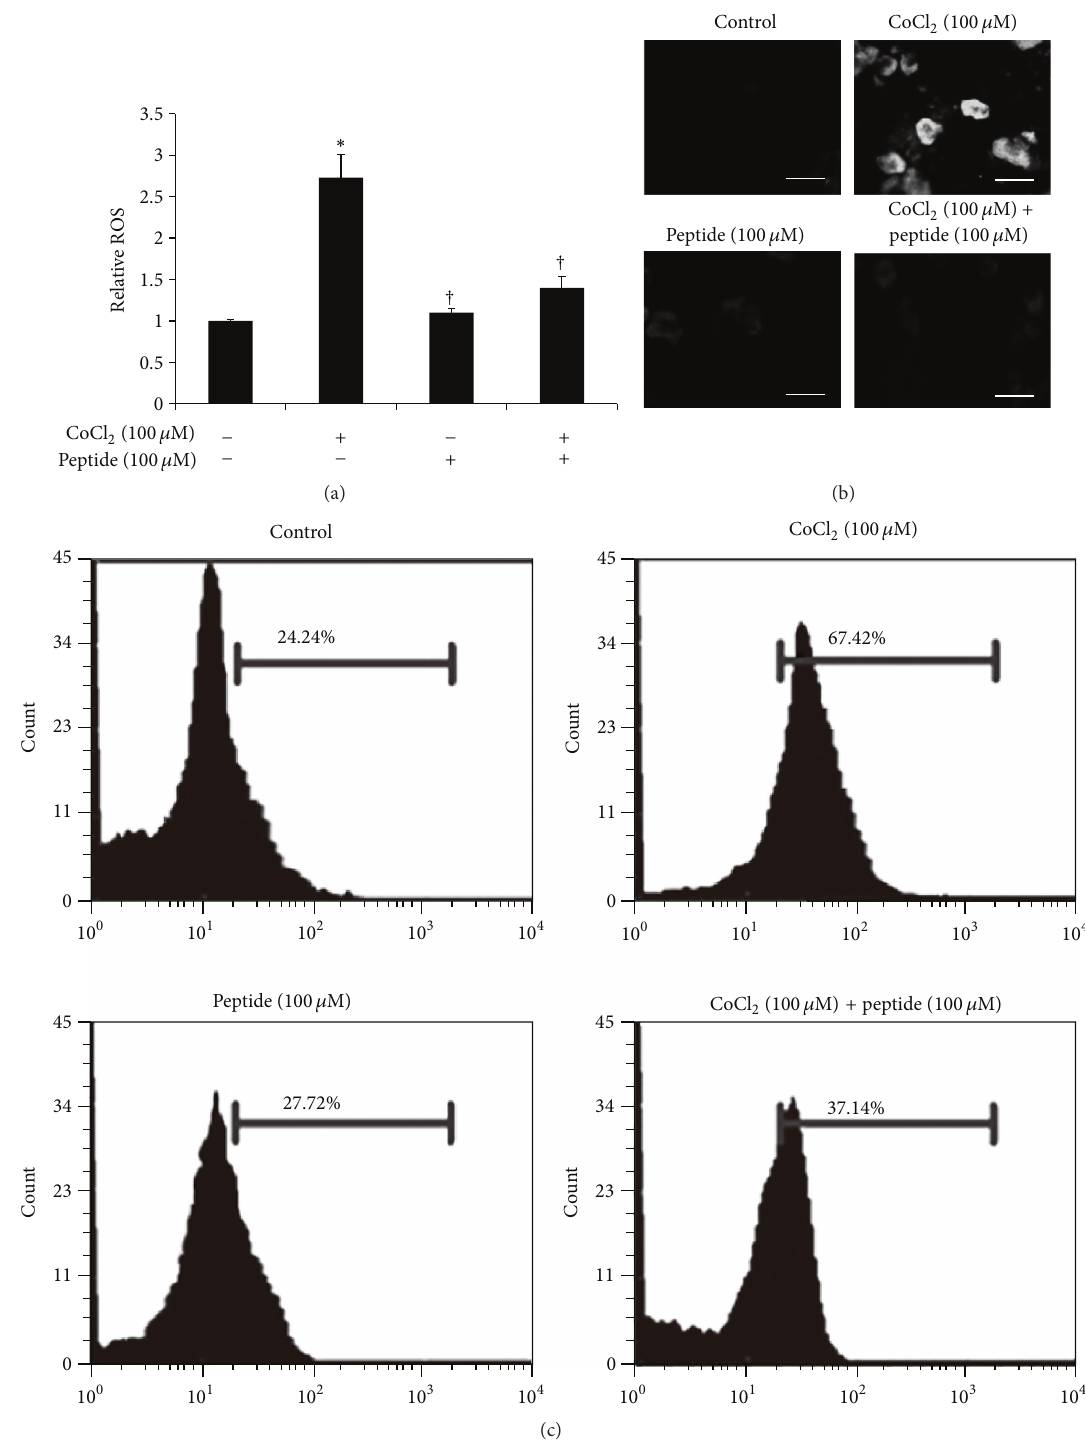
Figure 3: S. maxima peptide attenuates CoCl 2 -induced ROS level in HT1080 cells. (a) HT1080 cells (4 × 10 4 cells/well) were incubated in the presence or absence of 100 𝜇 M CoCl 2 and 100 𝜇 M peptide for 24 h. Cellular ROS levels were assessed by DCFH-DA. All data are presented as mean ± S.D. ∗ 𝑃 < 0.05 compared with blank; † 𝑃 < 0.05 compared with CoCl 2 control. (b) Representative images of HT1080 cells stained with DCF-DA. Intracellular ROS is observed with fluorescence microscopy (ZEISS, MIC00266). Bar, 10 𝜇 m. (c) Cellular ROS levels were determined by dihydroethidium (DHE) staining and flow cytometry assay. Representatives of at least 3 independent experiments are shown in the